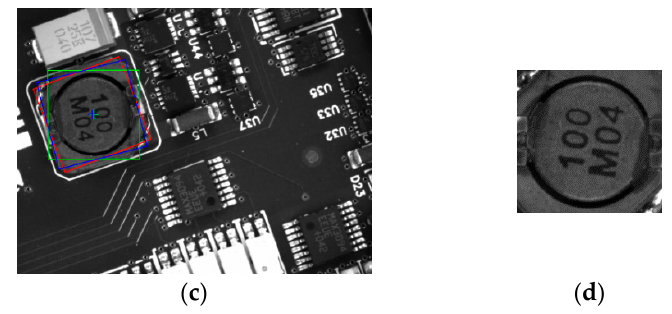
Figure 19. PCB case4 images. ( a – c ) real images and ( d ) template image (206 × 201 pixels).